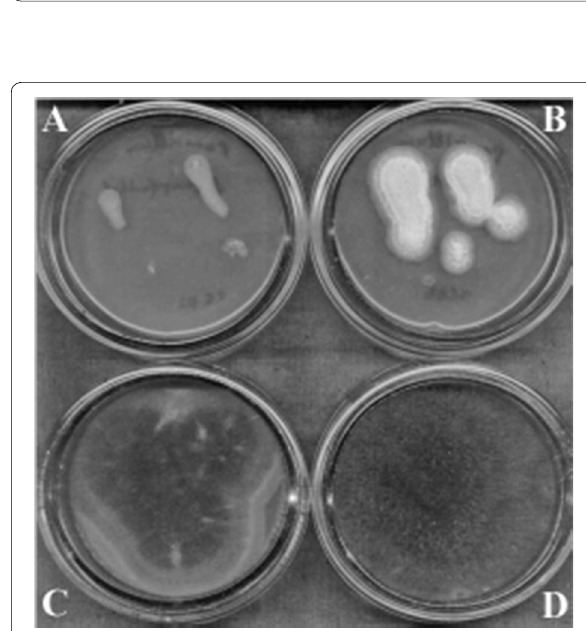
Fig. 2 The antifungal activity of L. rhamnosus MDC 9661 cell-free cultural liquid. A MDC 9661 supernatant with 10 4 spore/mL P. aurantioviolaceum spores, B control P. aurantioviolaceum without LAB supernatant, C MDC 9661 supernatant with 10 4 spore/mL M. plumbeus , D control M. plumbeus without LAB supernatant. For details see “Materials and